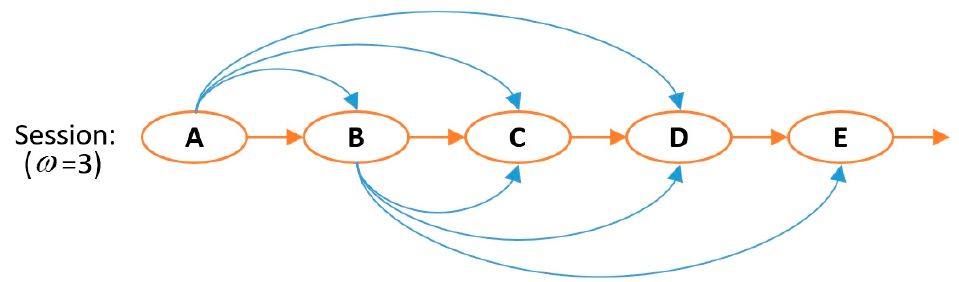
Figure 2. The influence range of A and B in a session when ω= 3 .